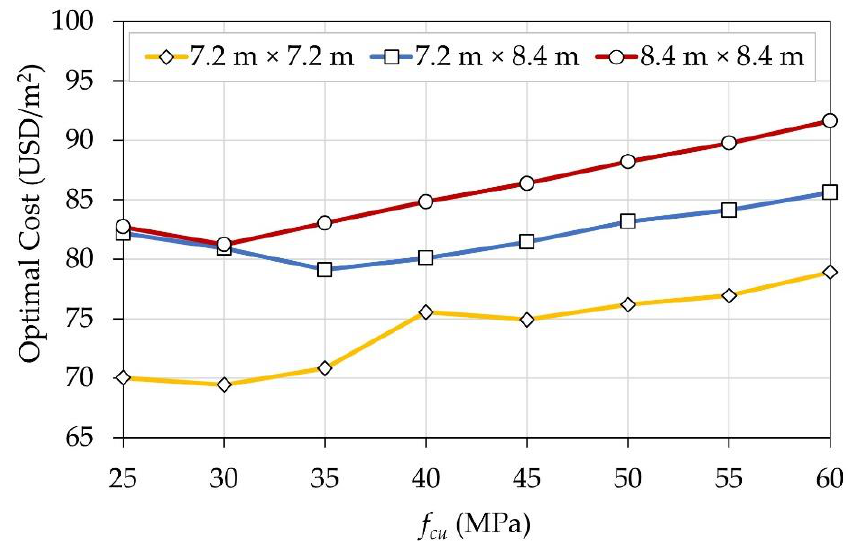
Figure 13. Comparison between FP design alternatives.